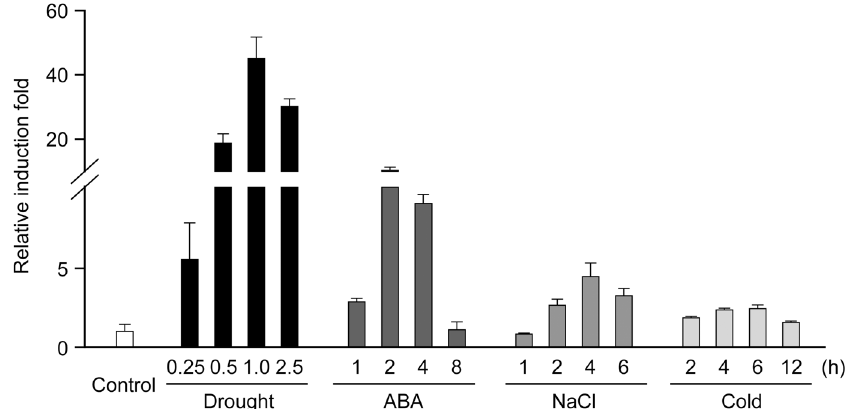
Fig 3. Expression of GpDSR7 in response to various abiotic-related stresses in G . pilifera . Rehydrated G . pilifera gametophytes were subjected to drought, ABA, high salinity, or low-temperature stress. Expression patterns of GpDSR7 were determined by qRT-PCR. GpDSR7 expression without treatment was set as 1.0. 18S rRNA was used as the internal